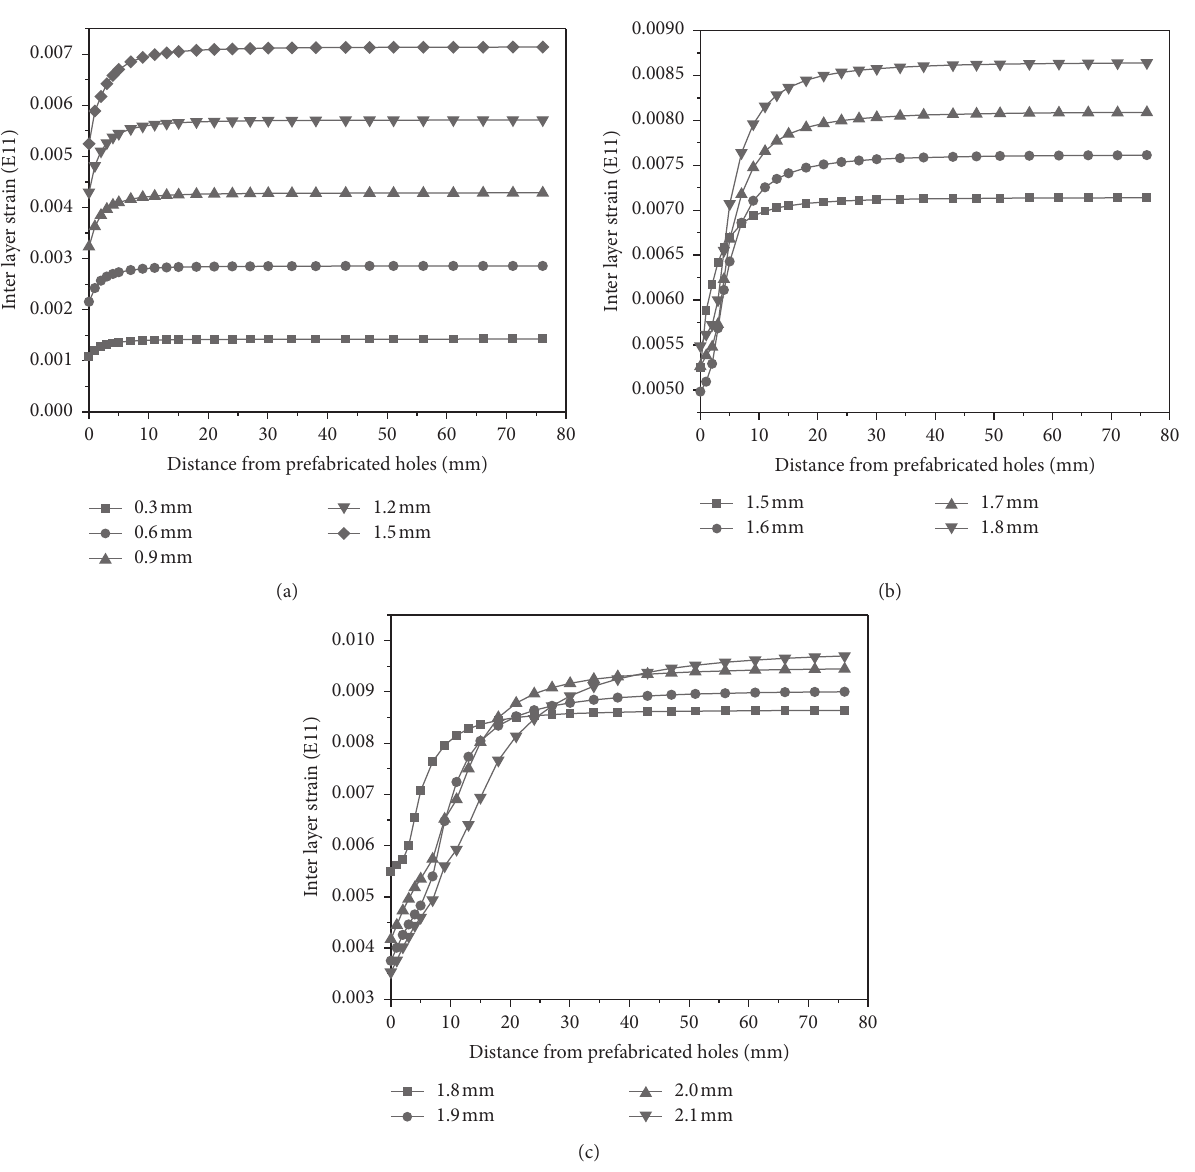
Figure 8: Strain among layers of CFRP laminated plates. (a) Strain among layers of CFRP laminated plates in the case of the tensile displacement of ends of 0.3 mm–1.5mm. (b) Strain among layers of CFRP laminated plates in the case of the tensile displacement of ends of 1.5mm–1.8 mm. (c) Strain among layers of CFRP laminated plates in the case of the tensile displacement of ends of 1.8mm–2.1 mm.